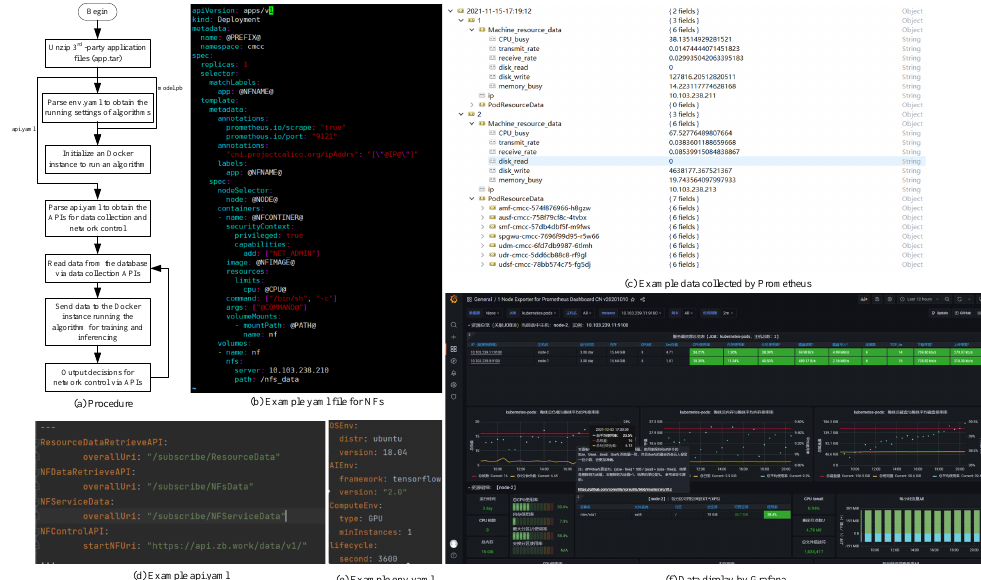
Figure 4. Procedure, example configuration file, and example